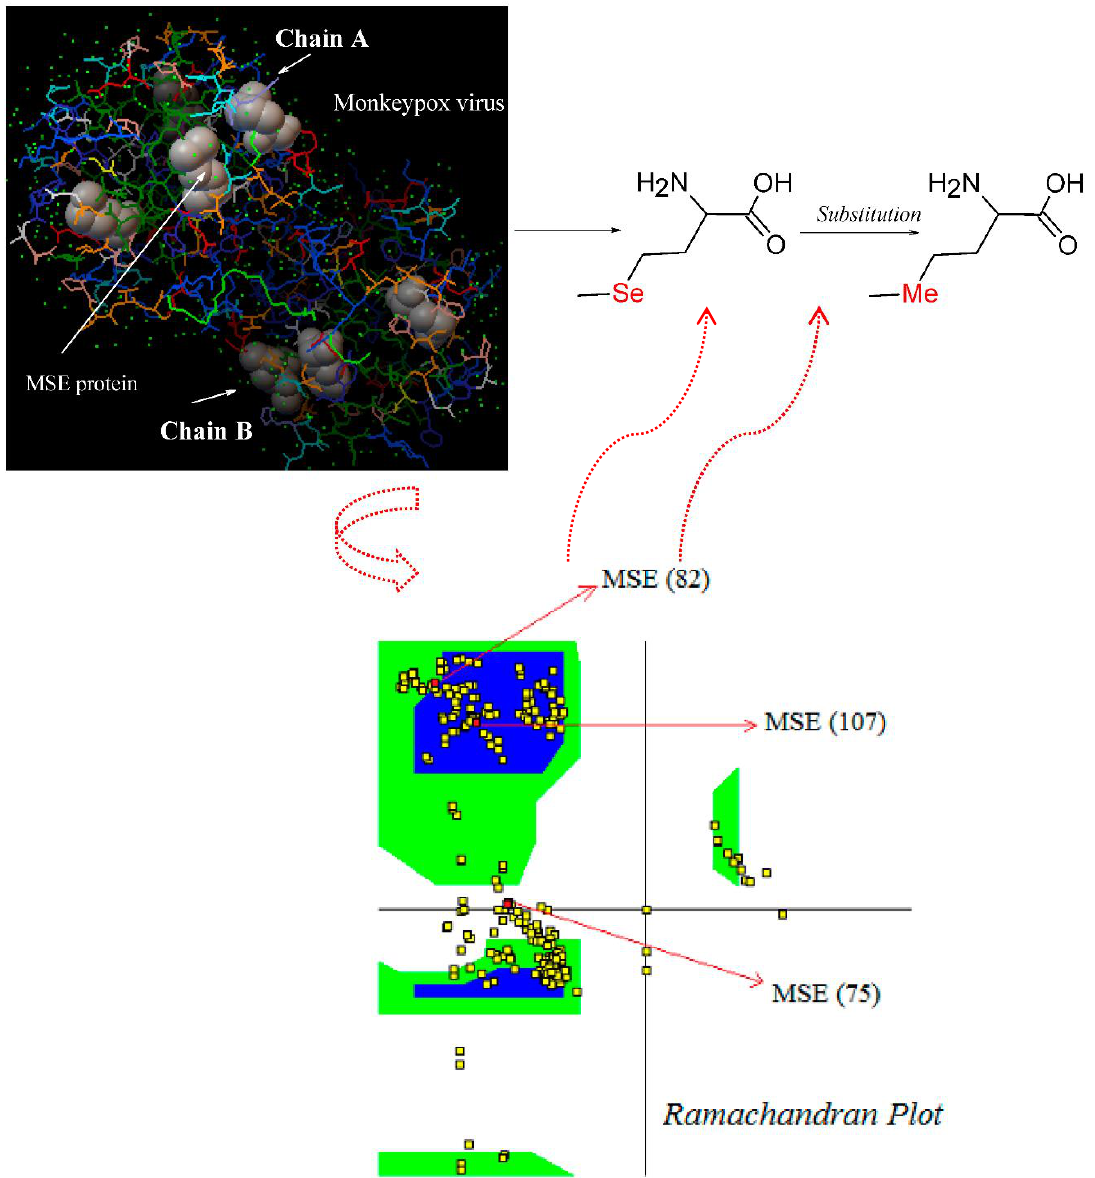
Scheme 1. 3D structure of Monkeypox virus with two chains of A and B, MSE protein, Rama- chandran Plot and substitution of serine with methionine in the